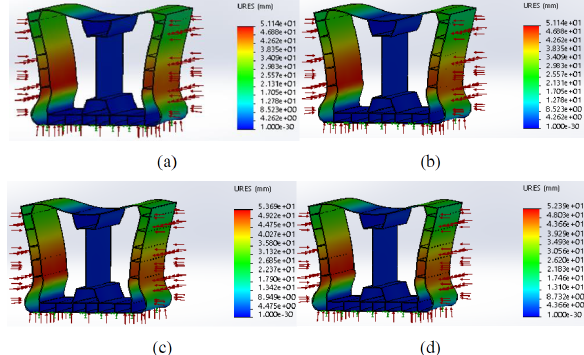
Figure 7: Deformation contour plots for different material types: (a) Grade AH36; (b) Grade AH32; (c) AISI 1020; and (d) AISI